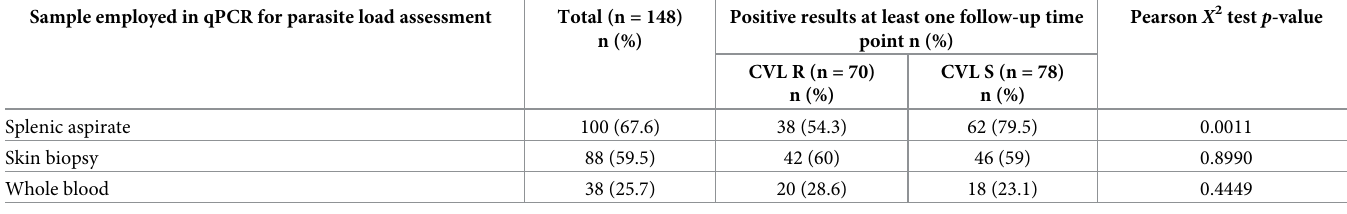
Table 3. Frequency of qPCR positive results at any time of the follow-up in visceral leishmaniasis resistant and susceptible dogs. Sample employed in qPCR for parasite load